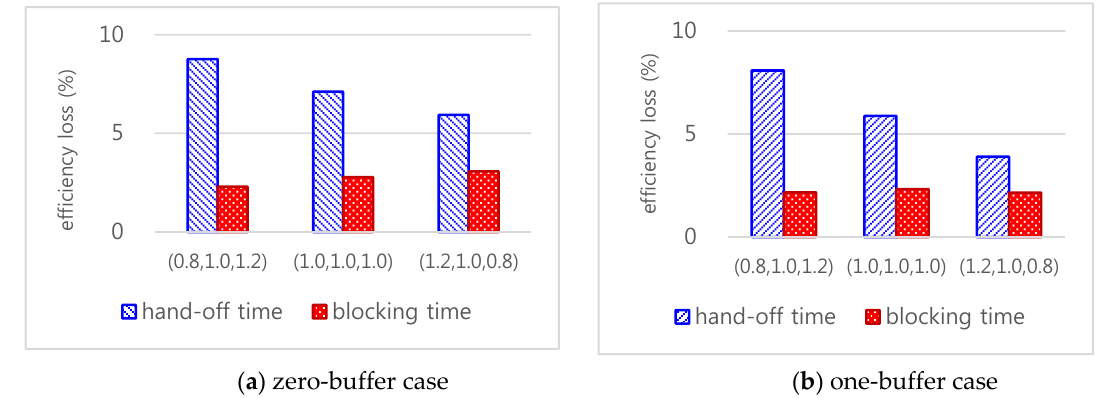
Figure 11. Efficiency losses caused by hand-offs and worker blocking with ( a ) buffer size of zero and ( b ) buffer size of one.